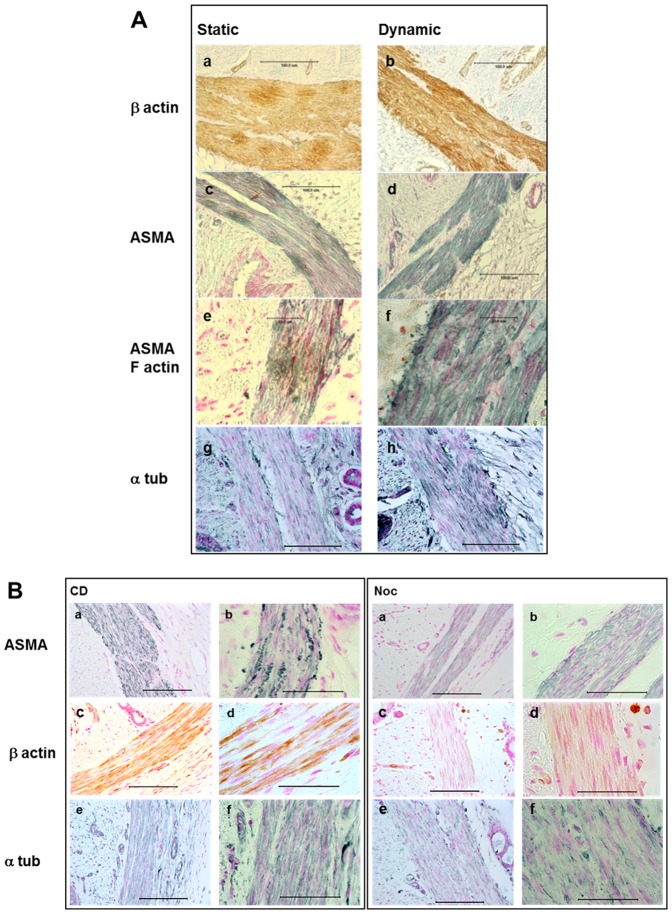
Airway constriction changes the subcellular structures of actin and microtubule.Single and double-labeled immunohistochemistry showing the distribution of β-actin, ASMA, the polymerized actin (F-actin) and α-tubulin on representative sections of bovine intact airways after static and dynamic Ptm conditions (90 min mechanical loading) and with constriction (A) and actin or microtubulin depolymerization (B). β-actin and F-actin are shown in brown; ASMA and α-tubulin are blue and nuclei are pink (A, and B). All conditions were processed simultaneously for each antibody (n = 30/condition). Scale bars are 100 µm on the top row sections and 50 µm on the bottom rows.